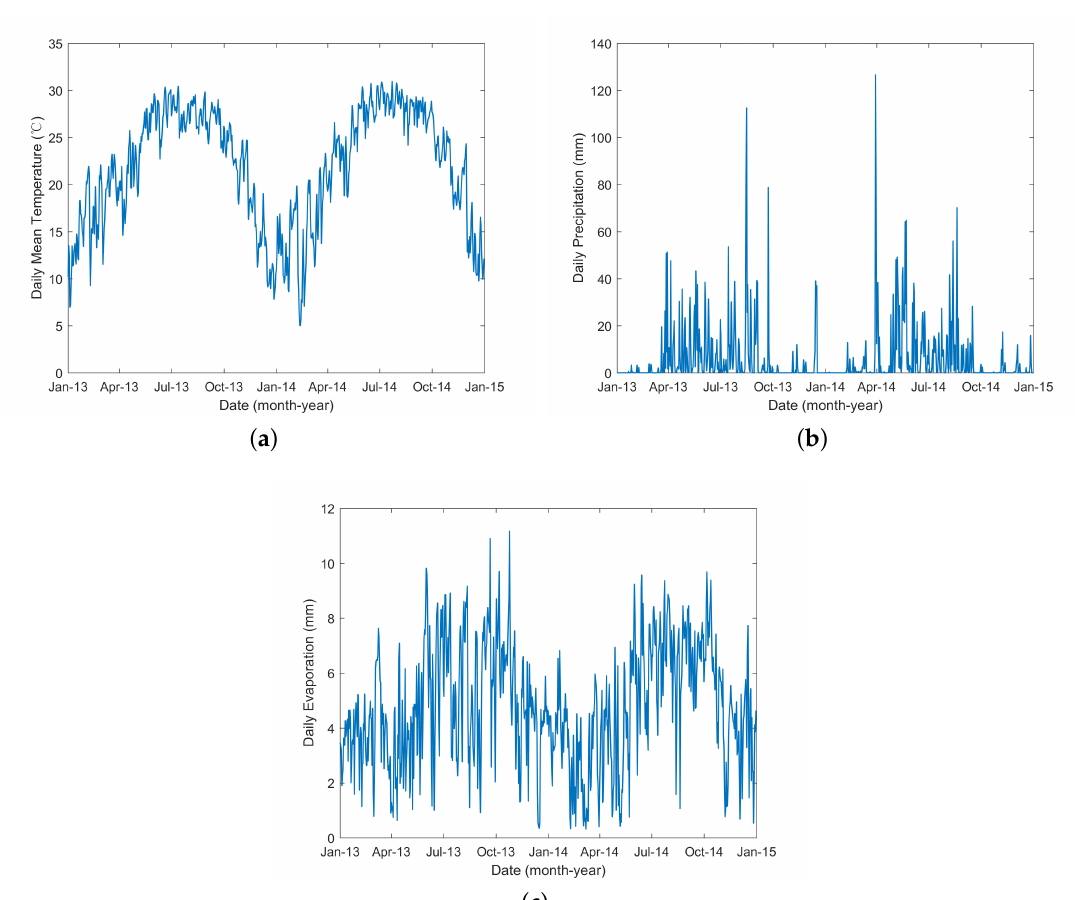
Figure 3. Daily temperature, precipitation and evaporation data from 2013 to 2014 for